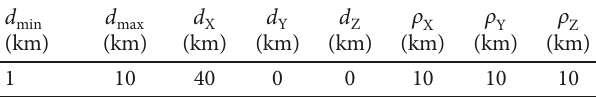
Table 2: Station-keeping box and relative distance